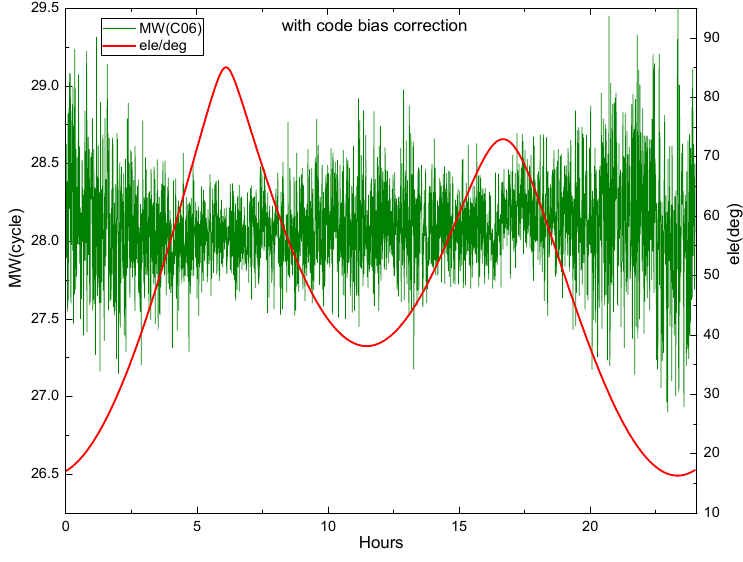
Figure 6. The corrected M-W variation of C06 at XMIS, on DOY 083, 2018 .